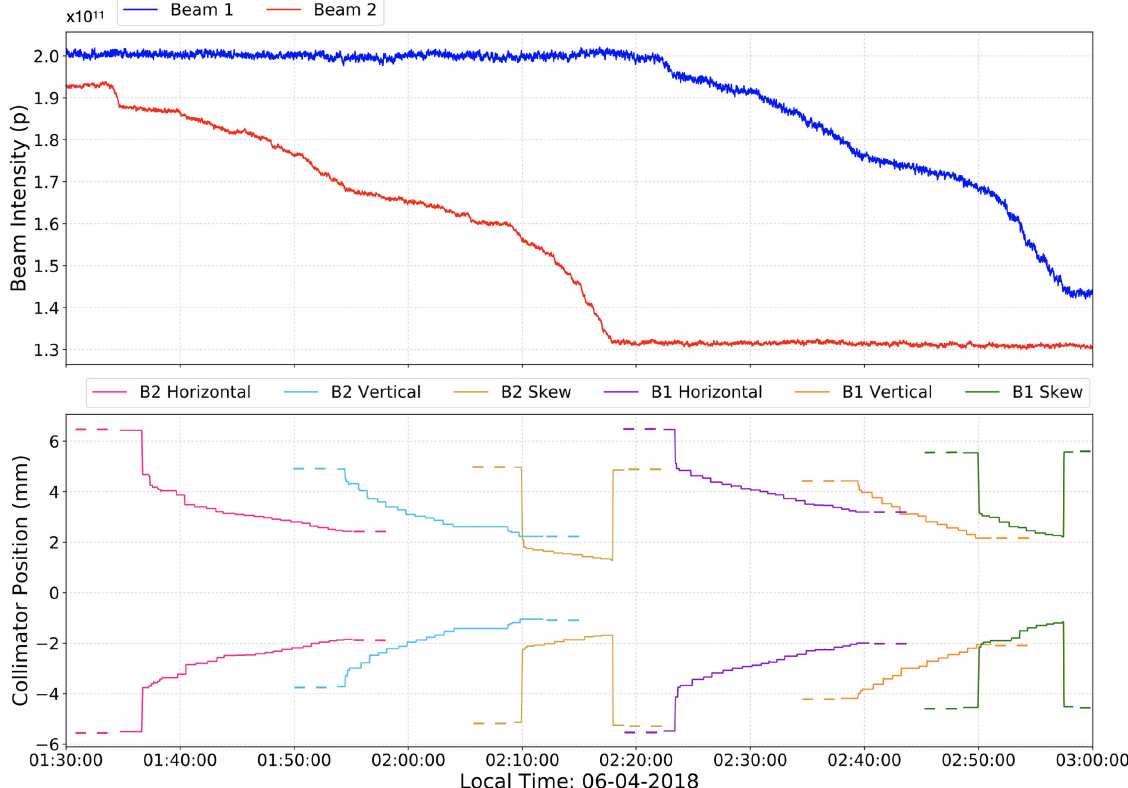
FIG. 7. Sequential alignment of the collimators in the two beams at injection, showing the beam intensities (top graph) and only the jaw positions of the primary (TCP) collimators (bottom graph) for